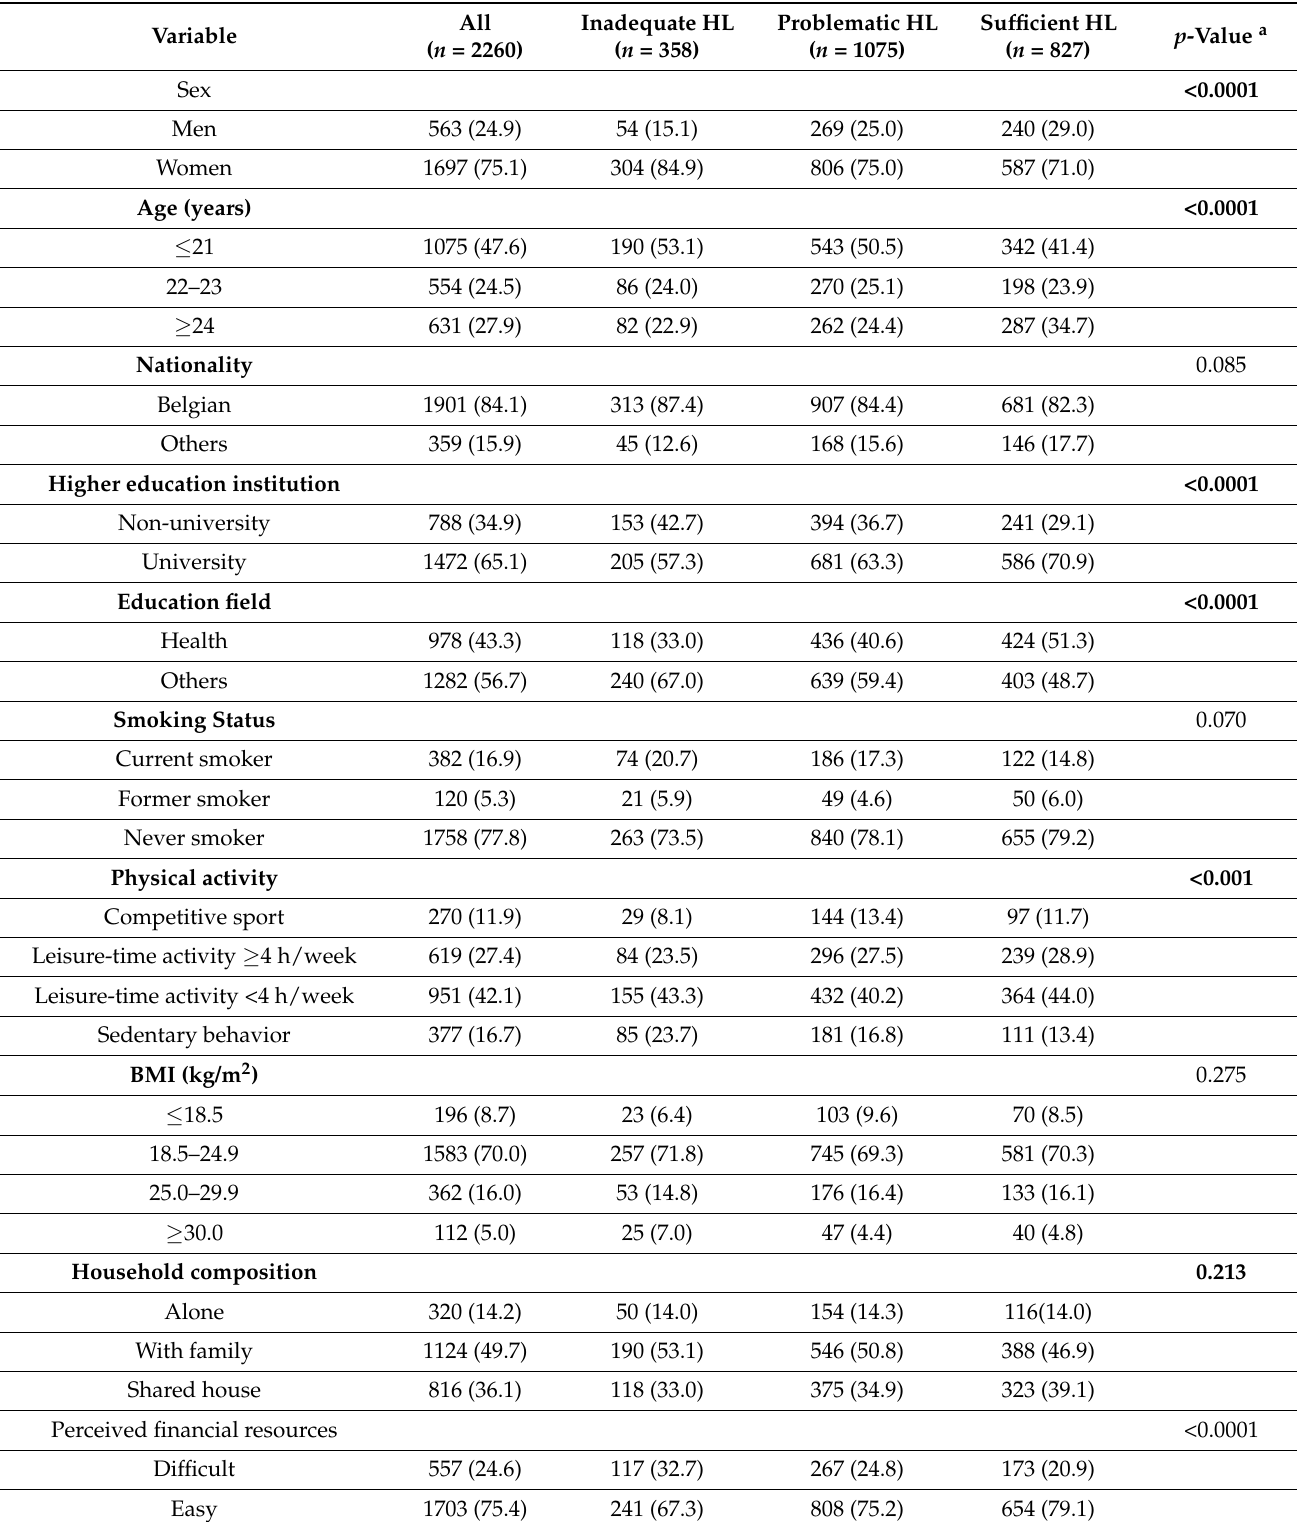
Table 1. Descriptive statistics of students’ characteristics globally and according to HL levels ( n =